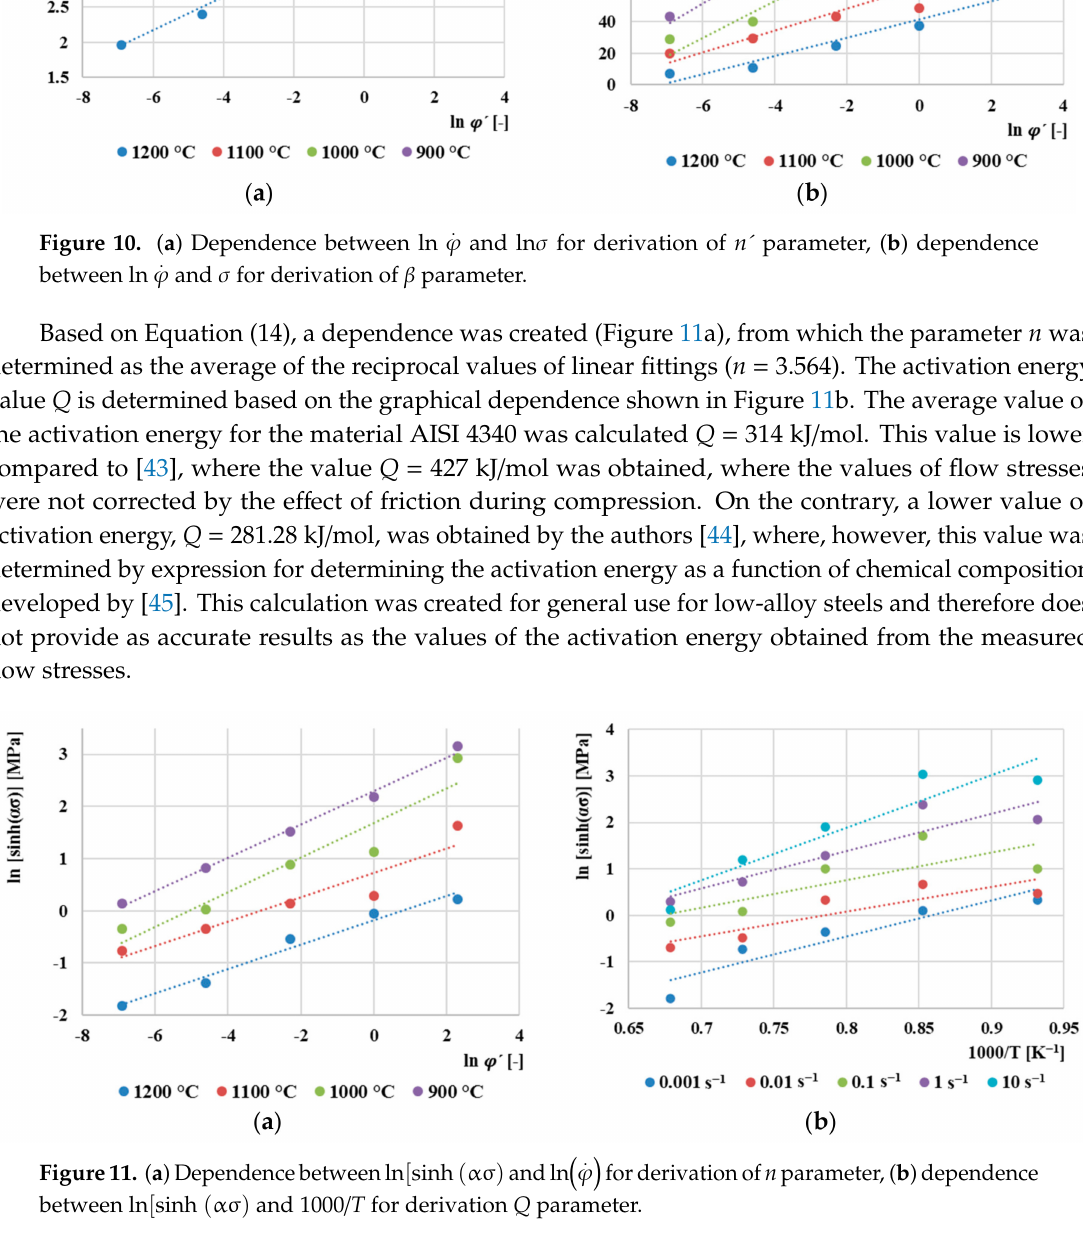
Figure 11. ( a ) Dependence between ln [ sinh ( ασ ) and ln between ln [ sinh ( ασ ) and 1000 / T for derivation Q